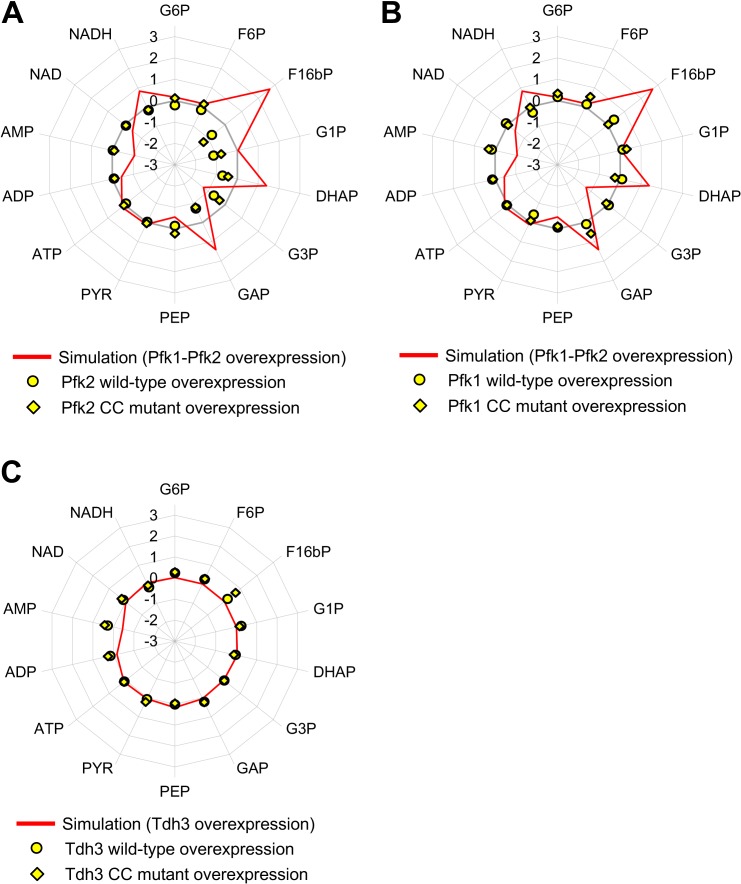
Comparison of metabolic changes triggered by overexpression of glycolytic proteins in silico and in vivo.The line graph shows the simulation result, and the data are the same as those used in Figure 4. Circles and diamonds show the metabolic measurements in vivo, and the data are the same as those used in Figure 5.